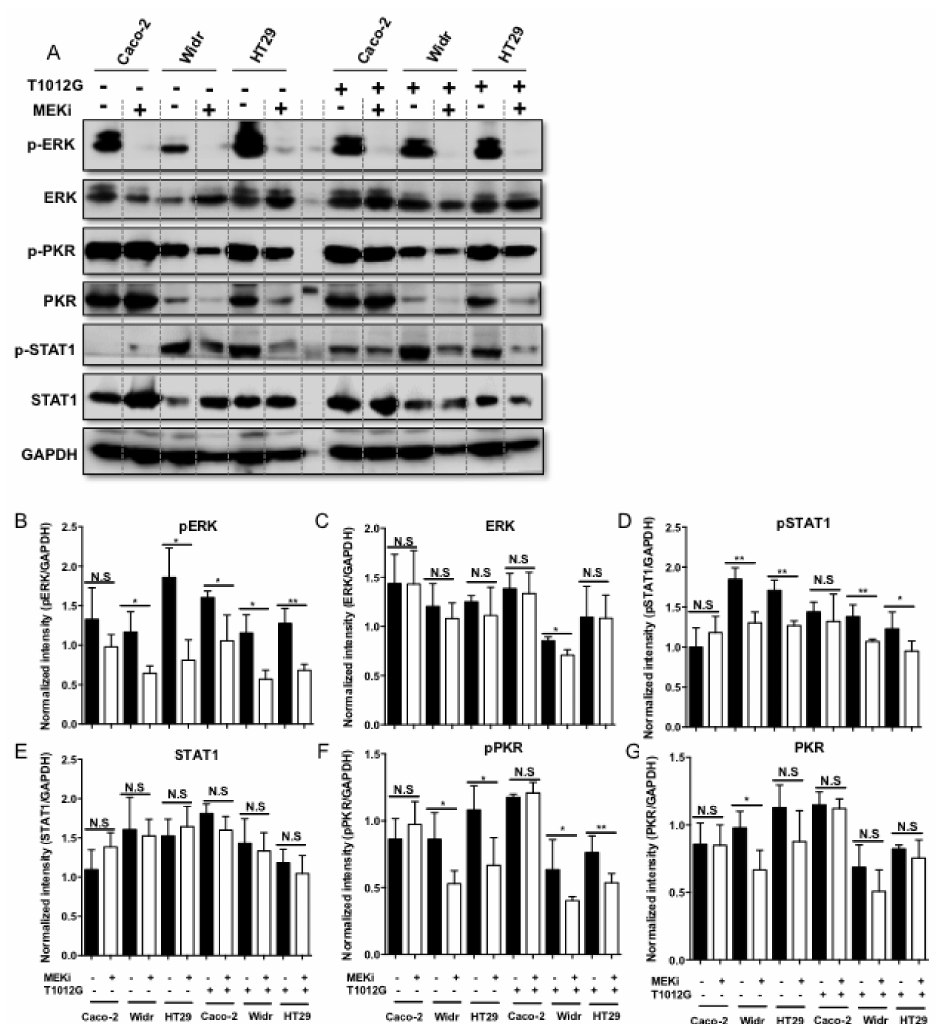
Figure 2. Down-regulation of STAT1 and PKR phosphorylation when combination of oHSV and MEKi in BRAF mutant cancer cells. ( A ) Caco-2, Widr, and HT29 cells were pretreated with 0.25 µ M of Trametinib (MEKi) for 2 h and then mock infected or infected with 0.1 PFU/cell T1012G. The cell pellets were harvested at 24 h post-infection, respectively, and lysates were analyzed by Western blotting for the indicated proteins. ( B – G ). Quantification of the protein level of pERK, ERK, pSTAT1, STAT1, pPKR, and PKR. N.S. (not significant); p > 0.05, * p < 0.05, ** p <